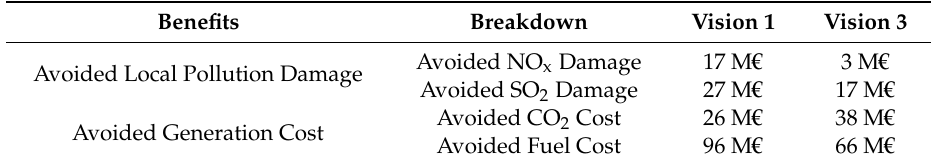
Table 5. Breakdown of the system-wide benefits of the project for Vision 1 and Vision 3 in 2030.